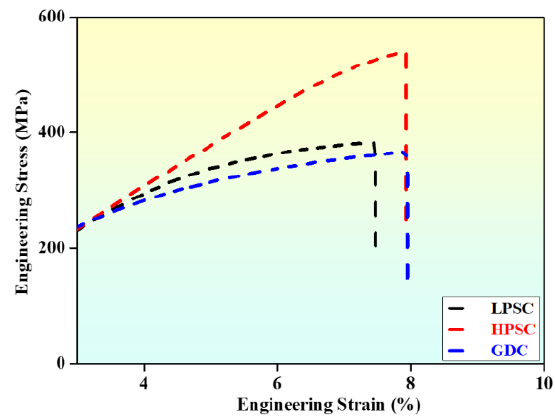
Figure 4. Engineering stress-strain curves of the cast samples fabricated under different conditions (gravity die-casting, low-pressure squeeze casting, and high-pressure squeeze casting). (gravity die-casting, low-pressure squeeze casting, and high-pressure squeeze